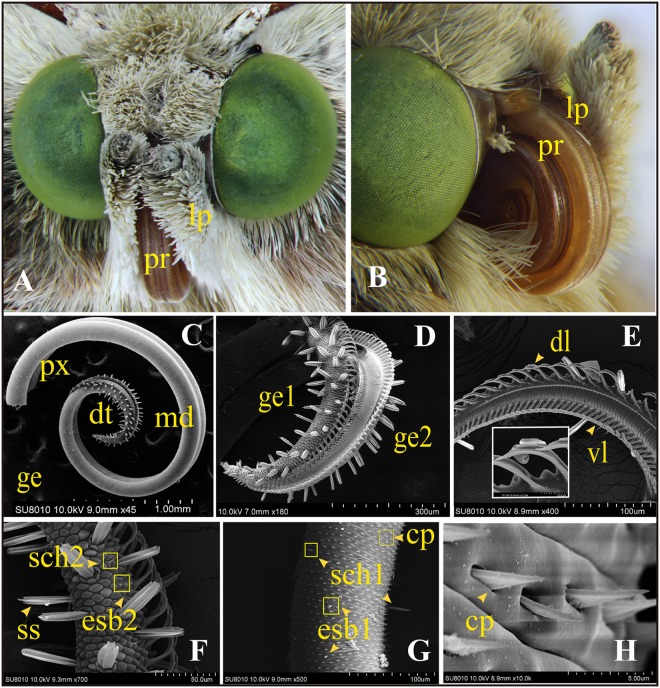
General morphology of the mouthpart organs and ultrastructure of the proboscis of adult Helicoverpa armigera. (A) Frontal view of the head shows the major siphoning mouthpart organs: proboscis (pr) and the pair of labial palps (lp). (B) The proboscis (pr) coiled up under resting state; one labial palp attached on the side (the other one was removed). (C–H) Scanning electron micrographs of proboscis. (C) Overall structure of proboscis: the rough distal section (dt) and the smooth proximal (px) and middle (md) sections were shown on the two elongated galeae (ge). (D) The distal section (dt) of two galeae shows many peg-shaped sensilla. (E) Dorsal (dl) and ventral ligulae (vl) on each galea. (F) Two major sensilla on the distal section: sensilla styloconica (ss), external sensilla basiconica subtype 2 (esb2) and sensilla chaetica subtype 2 (sch2). (G) Two types of sensilla on the proximal and middle sections: external sensilla basiconica subtype 1 (esb1) and sensilla chaetica subtype 1 (sch1). Plenty of cuticular processes (cp) arranged on the surface. (H) Triangular structure of cuticular processes.